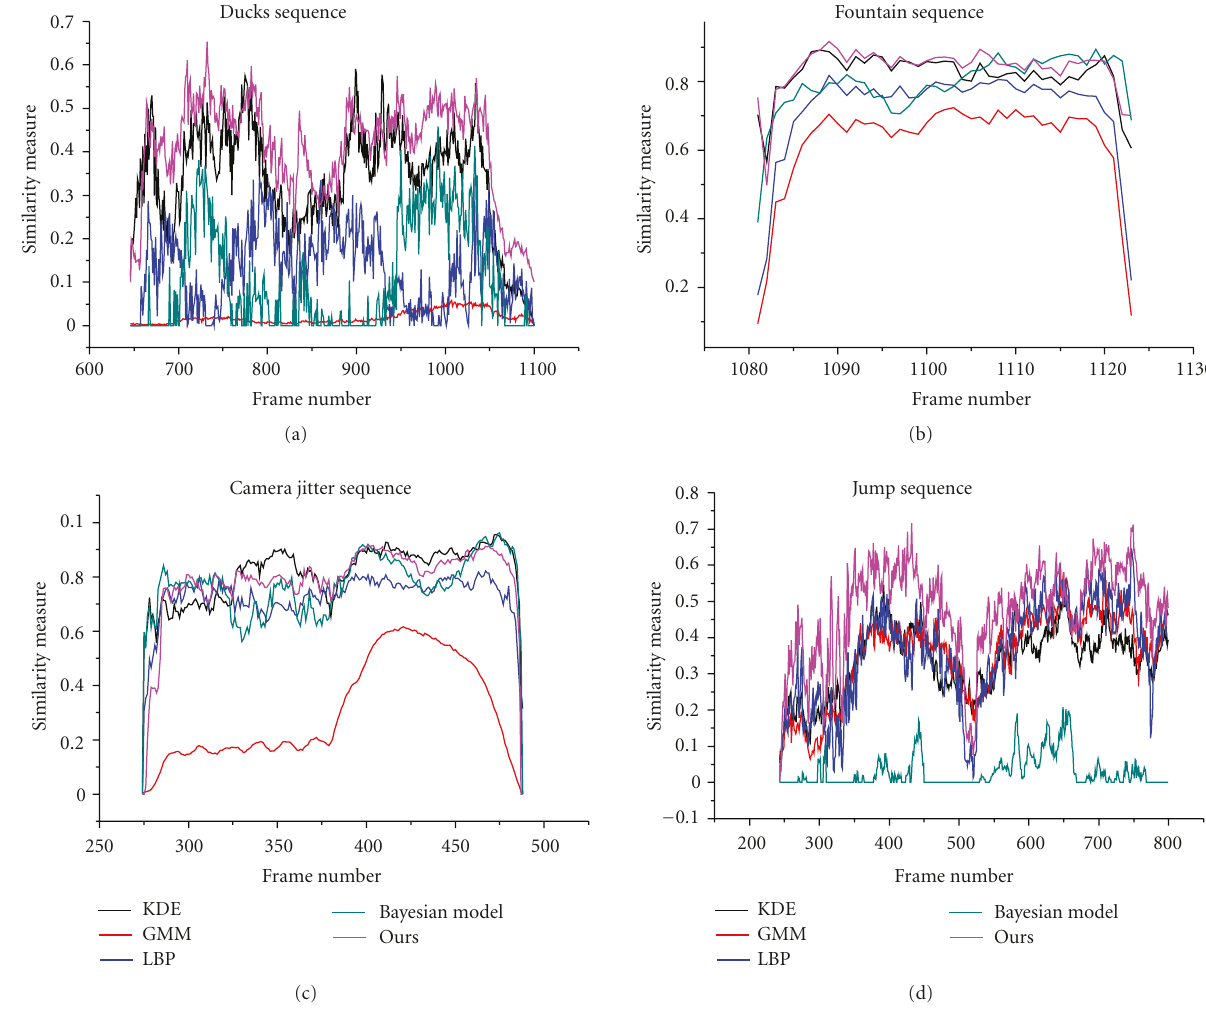
Figure 10: Quantitative comparison results of the five BGS algorithms on the Ducks, Fountain, Camera Jitter and Jump sequence. The similarity measure used to evaluate the detection results of foreground objects is defined in